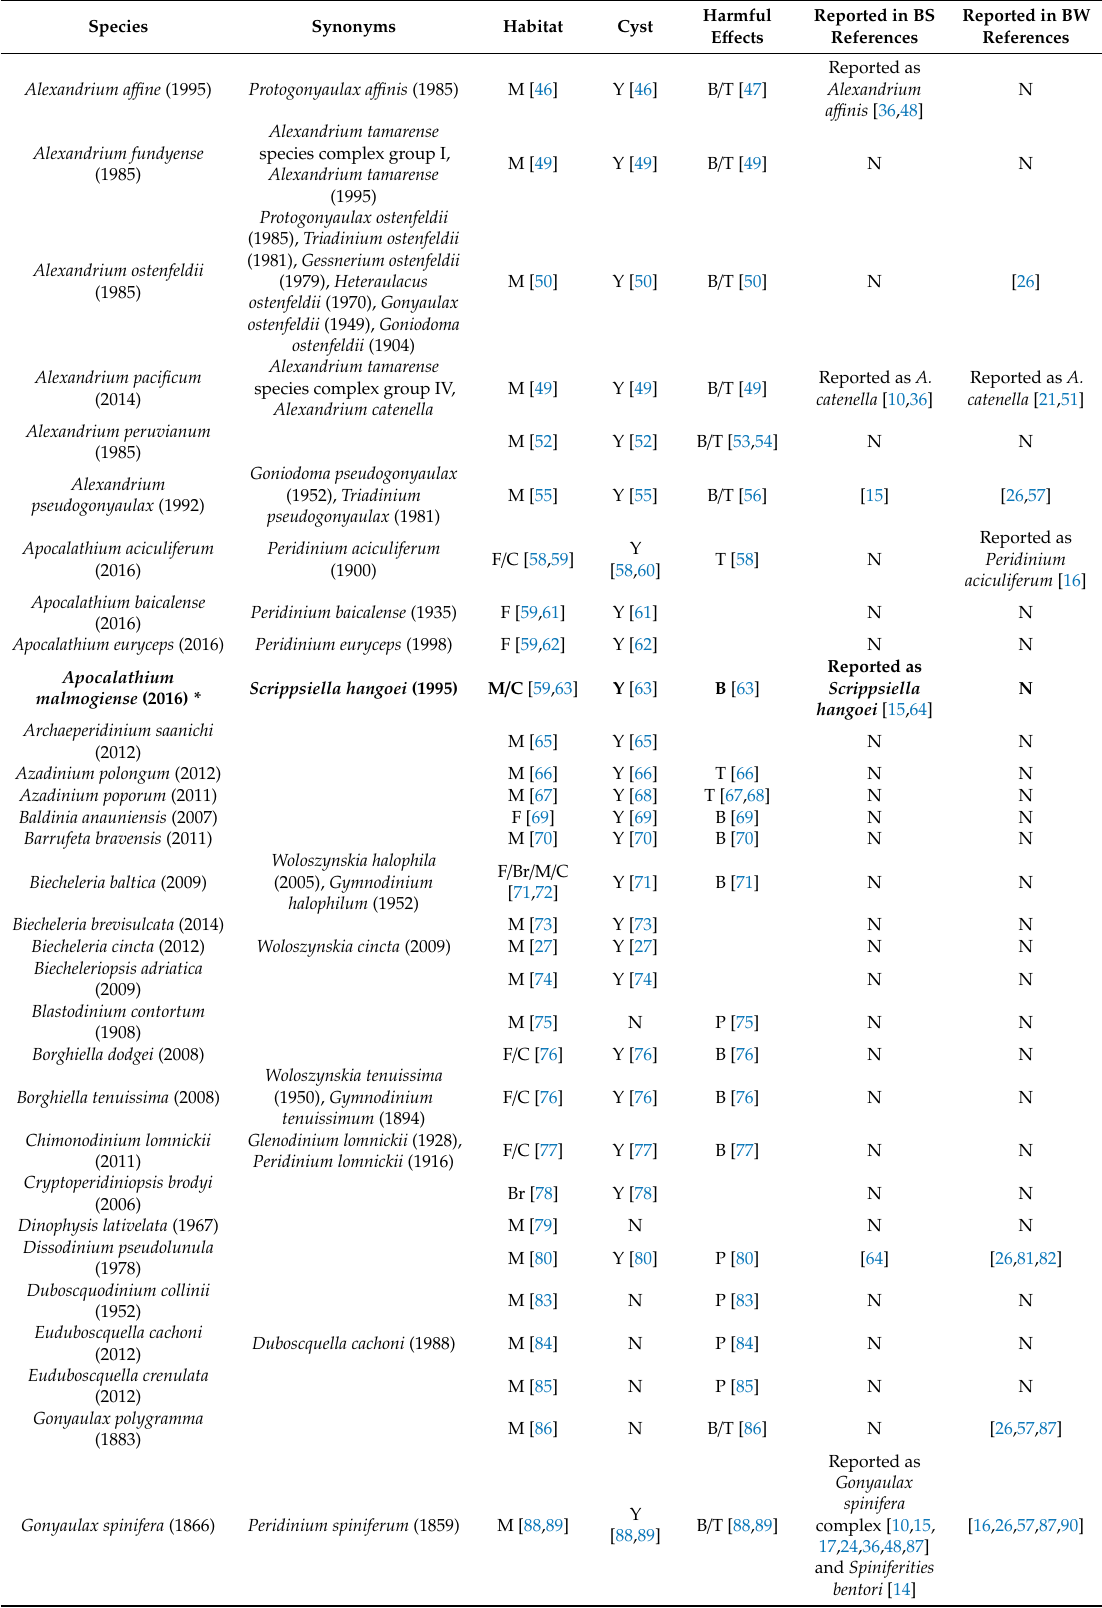
Table 2. Dinoflagellate species fully identified in ballast tank sediments collected from ships entering the Great Lakes or Chesapeake Bay,